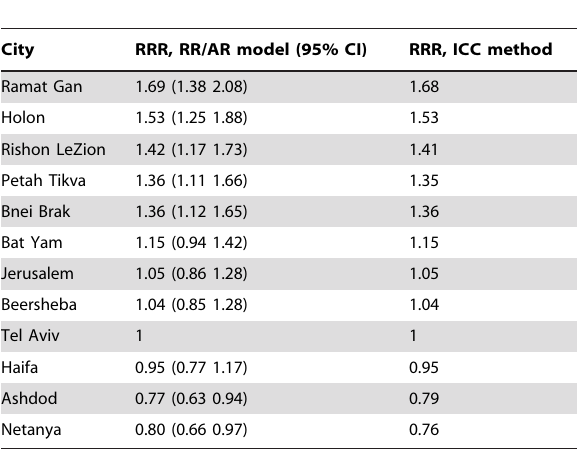
Table 2. Estimates for the reporting rate of each city relative to the reporting rate of Tel Aviv (Relative Reporting Rate, RRR) found using the RR/AR model (middle) and the incidence curves comparison method